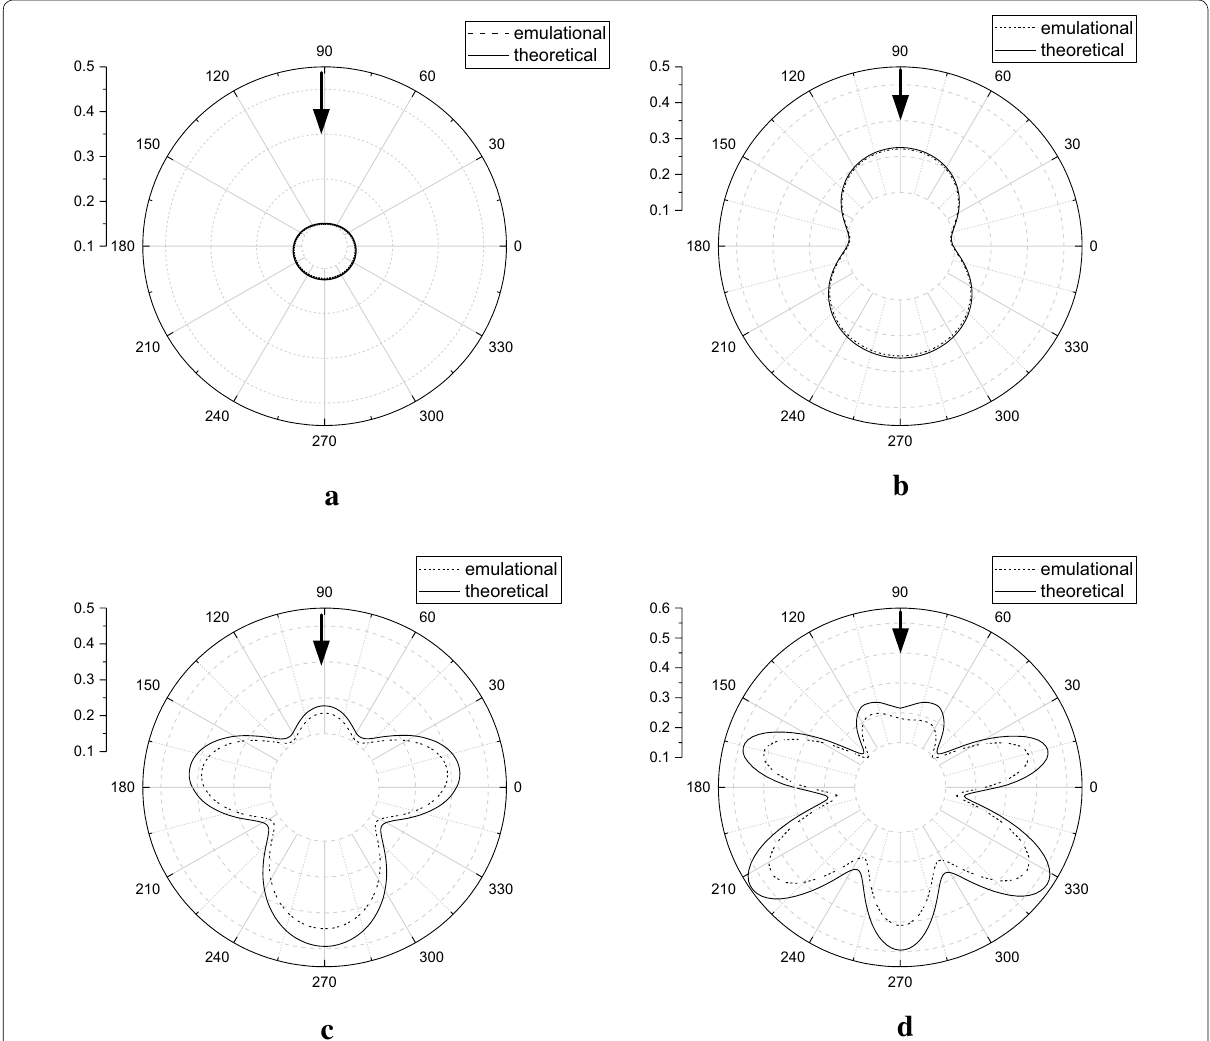
Figure 2 Angular distribution of scattered pressure of plane wave from simulation results and theoretical solutions versus ka ( f = 235 kHz, 850 kHz, 1109 kHz, and 2348 kHz ) incident pressure amplitude is one, plane wave width is 2.8 mm, and cylinder radius is 2 mm): a ka = 0.5 , b ka = 1.8 , c ka = 3.0 , and d ka = 5.0 . The arrows represent the plane wave